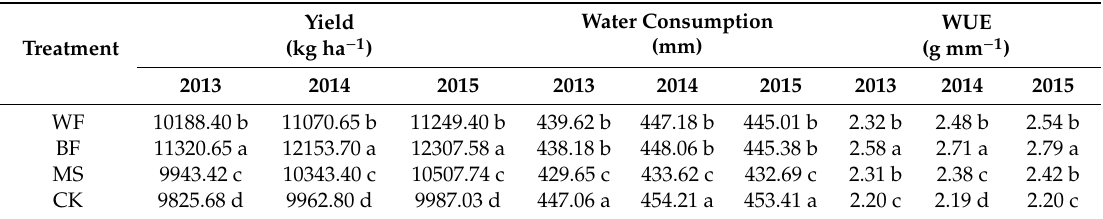
Water Consumption